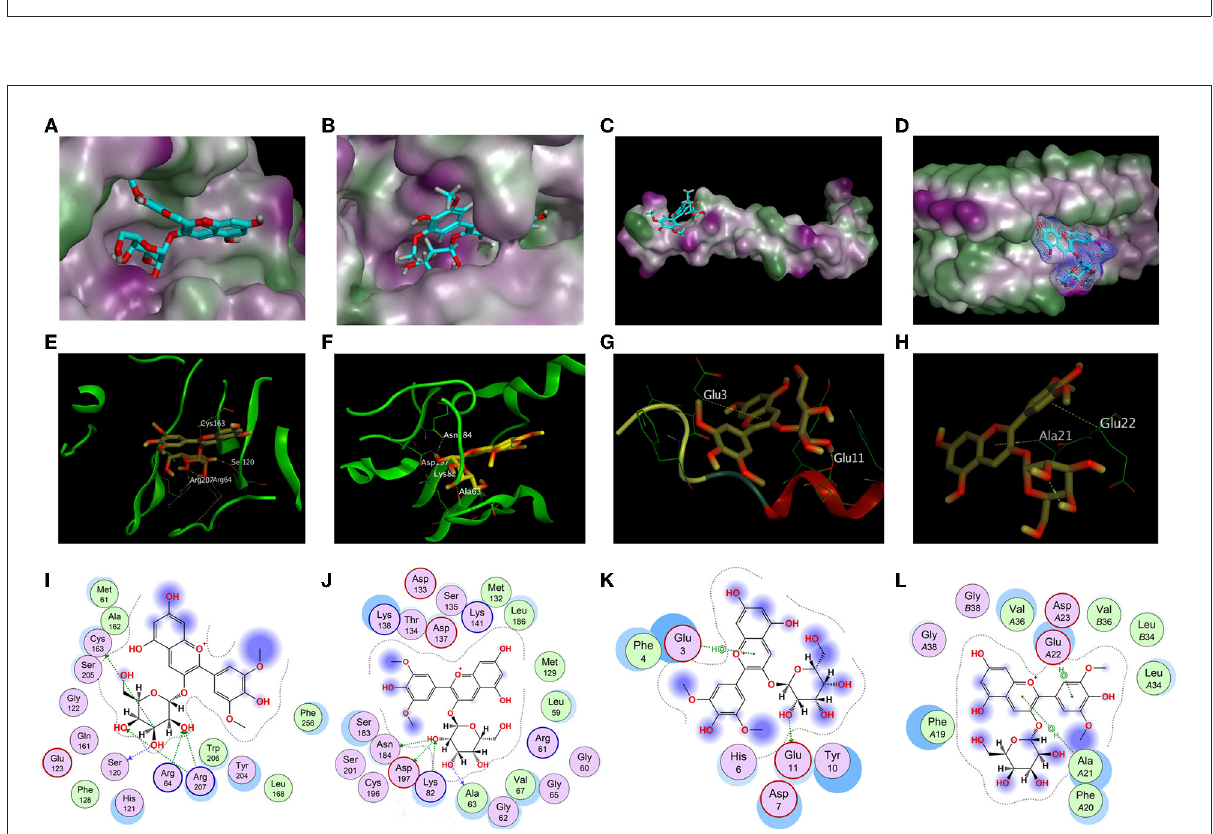
FIGURE8 Docking results of Ma-3-gal-Cl. (A,E,I) The best binding pose, side view, and interaction graph of Ma-3-gal-Cl docked into the crystal structure of caspase-3 (PDB ID: 2J33). (B,F,J) The best binding pose, site view, and interaction graph of Ma-3-gal-Cl docked into the crystal structure of MKK6 (PDB ID: 3VN9). (C,G,K) The best binding pose, site view, and interaction graph of Ma-3-gal-Cl docked into the crystal structure of A β (1–42) monomer (PDB ID: 1IYT). (D,H,L) The best binding pose, side view, and interaction graph of Ma-3-gal-Cl docked into the crystal structure of A β (1–42) fibril (PDB ID: